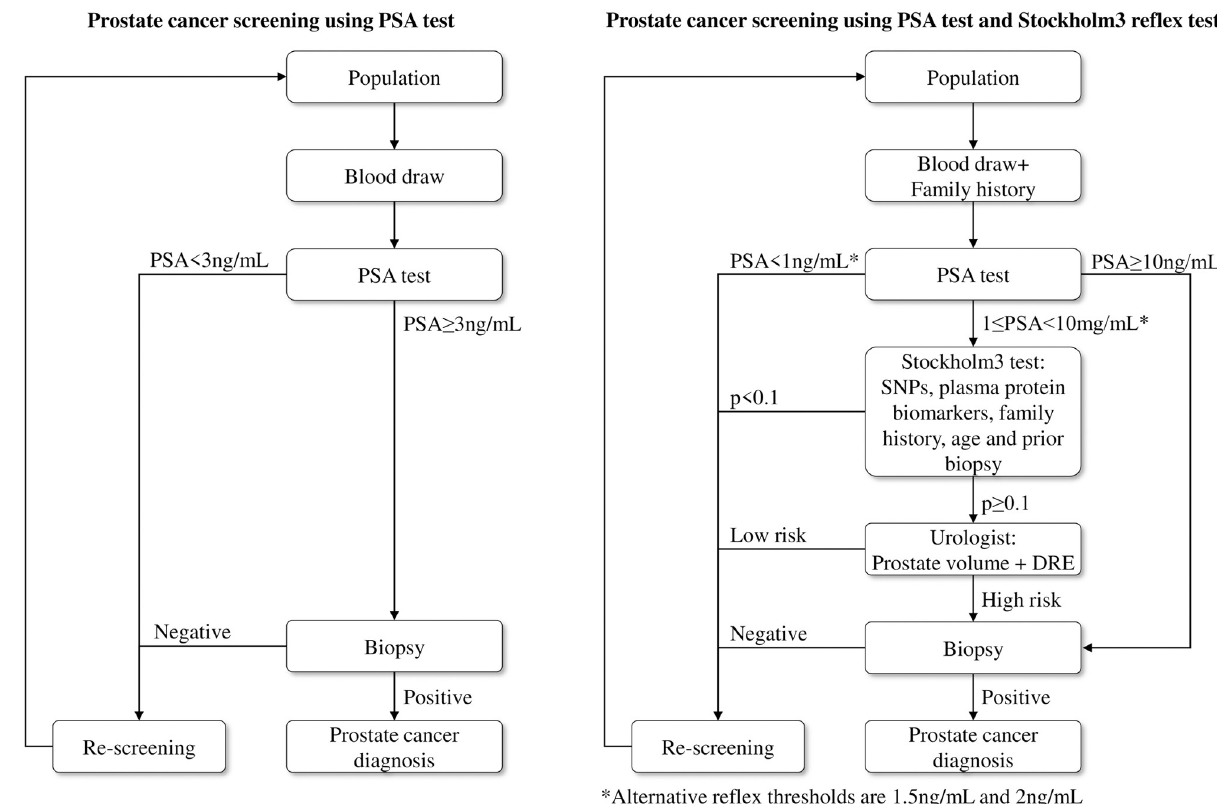
Fig 1. Prostate cancer screening interventions using PSA test and the S3M reflex